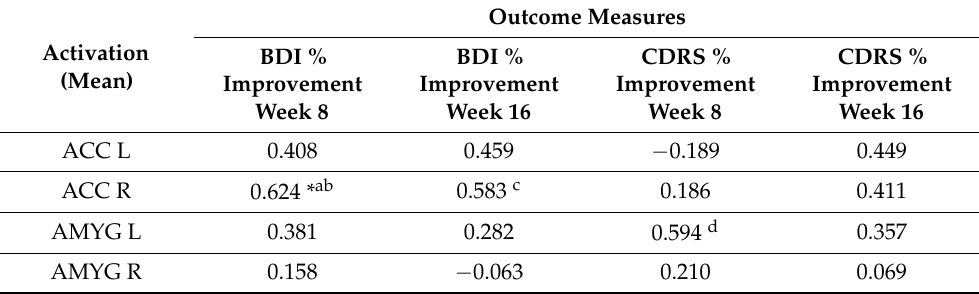
Table 4. Results (standardized Beta coefficients) of linear regression analyses modeling average brain activation within the context of the emotion-matching task as a predictor of clinical